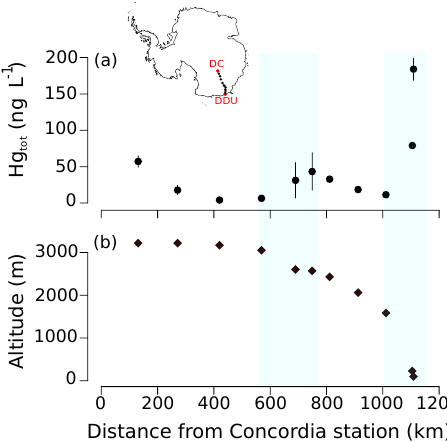
Figure 10. (a) Total mercury concentration in surface snow samples (Hg tot in ngL − 1 ) along with standard deviation and (b) altitude (m) vs. distance from Concordia station (DC) during the traverse from DC to DDU. Hg tot concentrations increased in areas highlighted in blue, characterized by steeper slopes and higher snow accumulation values. All samples were analyzed in replicates of three. Standard deviation is frequently smaller than the width of the